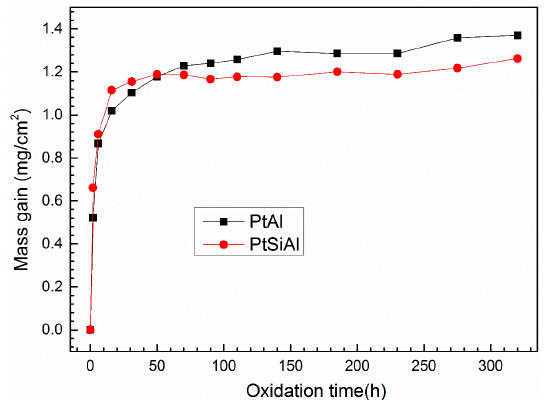
Figure 4. Kinetic curves of the PtAl and PtSiAl coatings after isothermal oxidation at 1100 °C for 320 h.